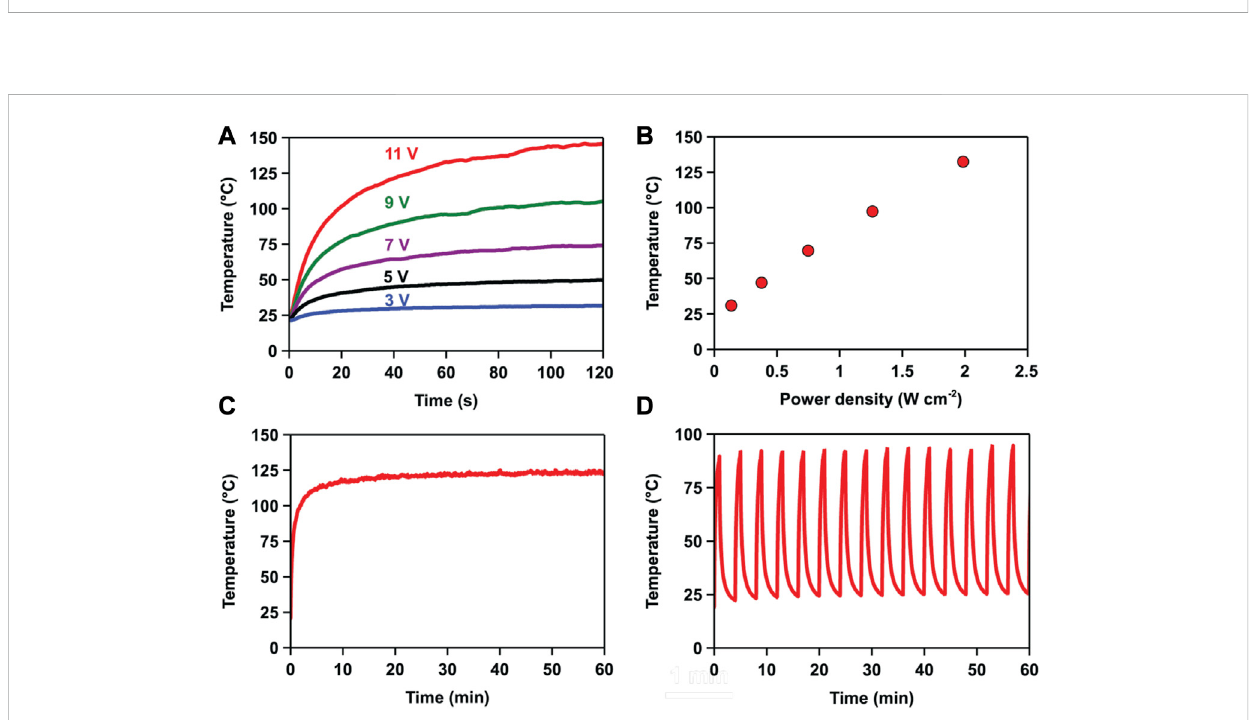
FIGURE 4 Evaluation of the electrothermal performance of produced nanocomposite fi lms. (A) Temperature pro fi les of a nanocomposite fi lm heater in responsetovariousinputvoltages. (B) Relationshipbetweeninputpowerdensityandsteady-statetemperature. (C) Staticelectrothermalstabilitytestata constant input voltage of 9 V. (D) Cyclic stability test by varying the input voltage between 0 and 9